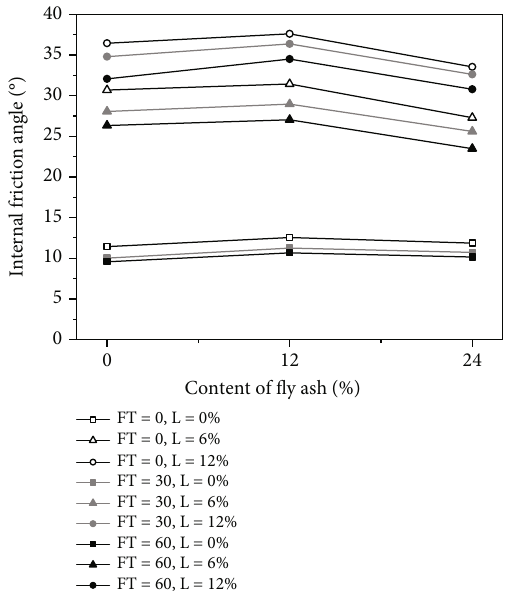
Figure 20: Peak deviatoric stress due to di ff erent content of fl y ash ( FT = 30 ).